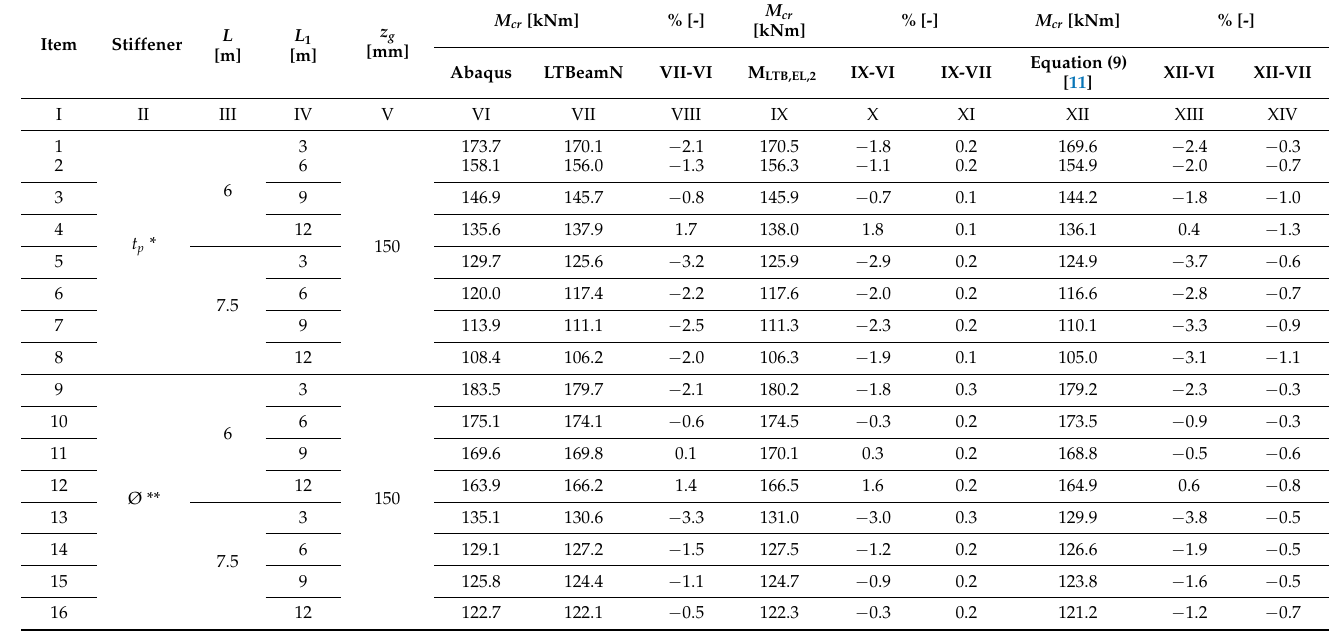
Table 7. Comparison of M cr for uniformly loaded ( z g = + h /2) B–E critical beam of the